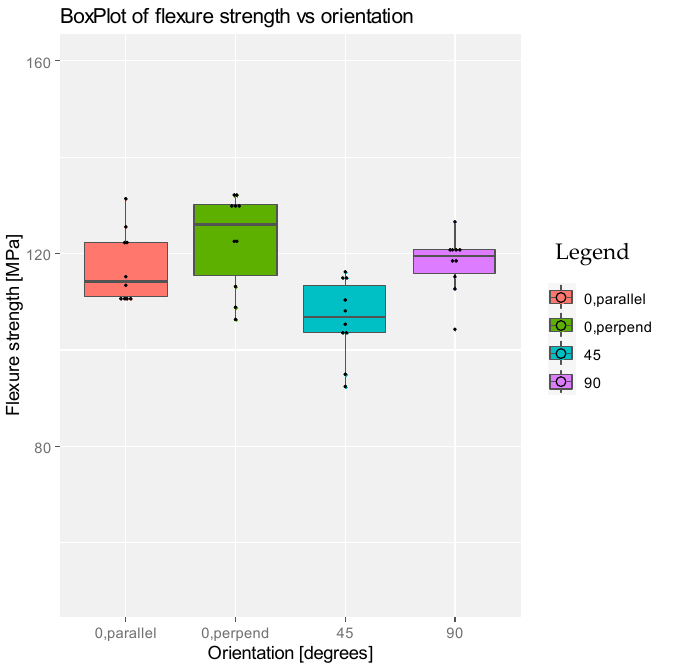
Figure 5. Boxplot representation for the flexure strength with respect to degrees of printing angle for the product NEXTDENT.